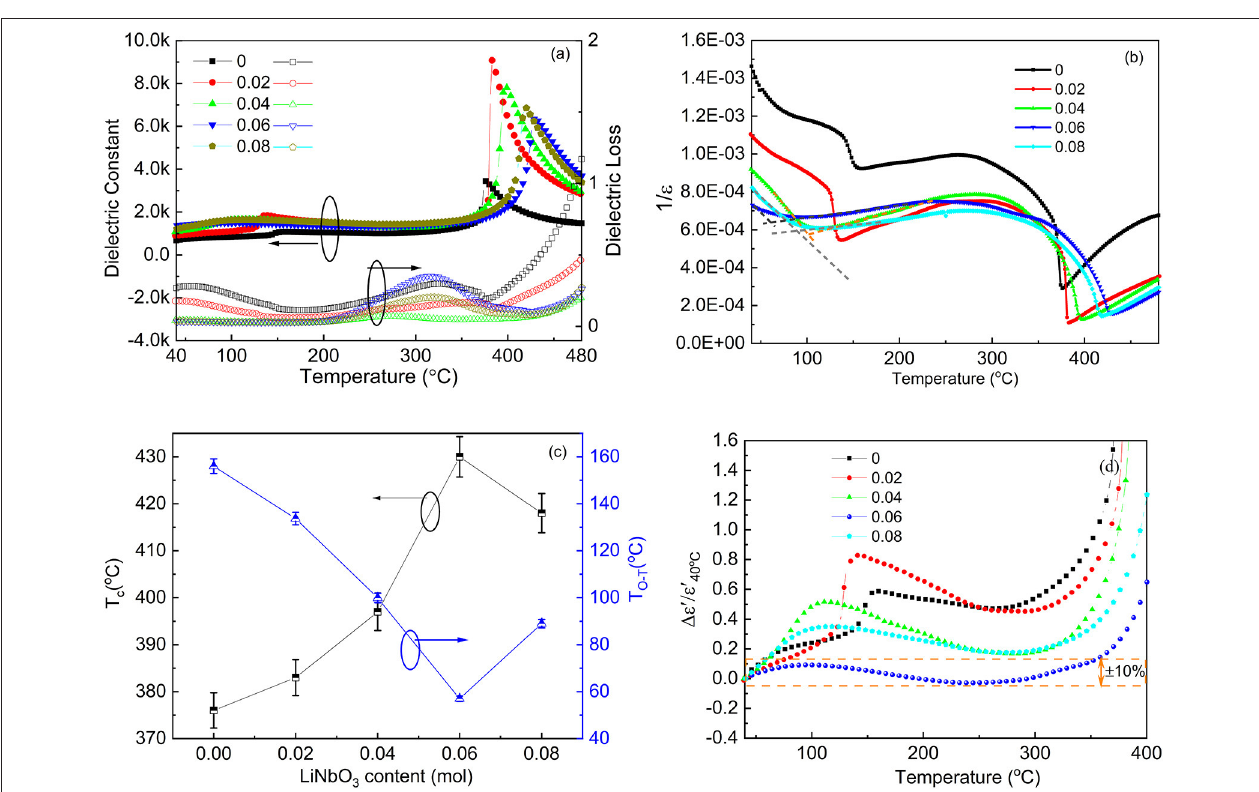
Frontiers in Materials |